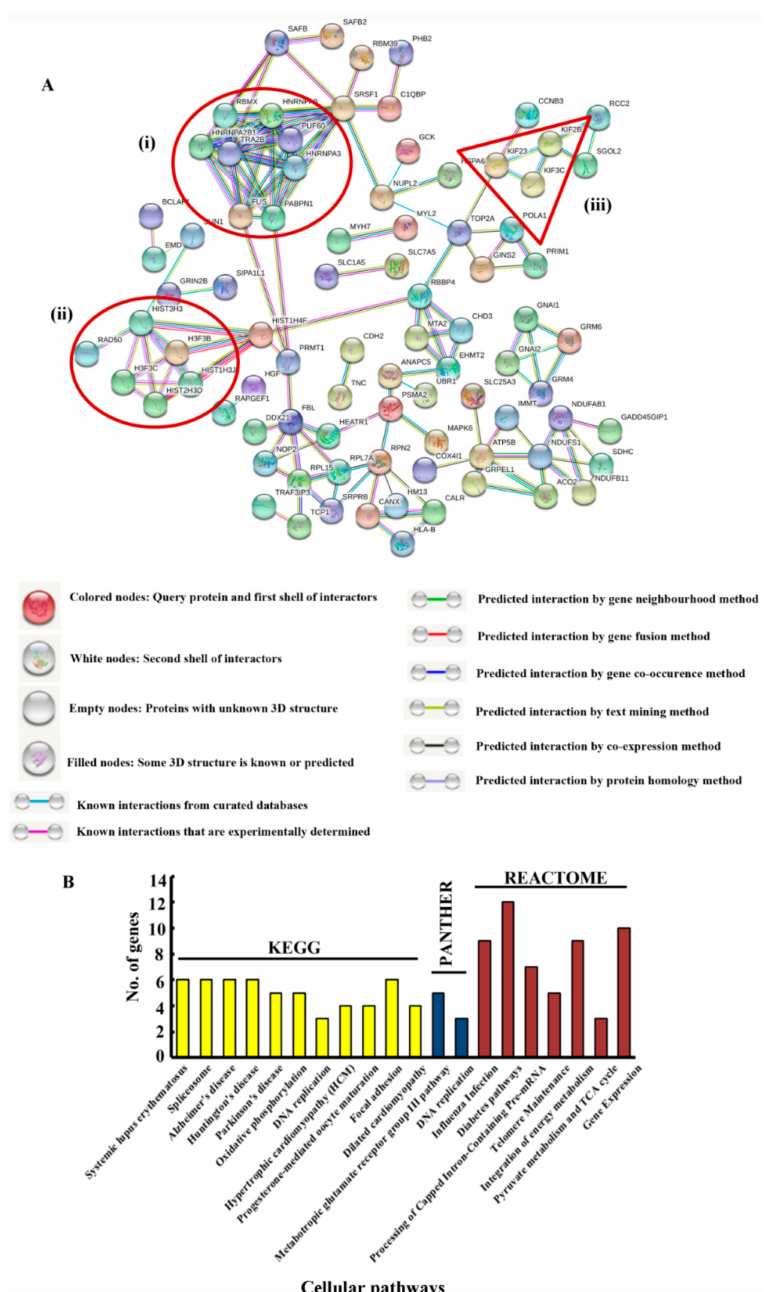
Figure 4. ( A ) The interactome of the downregulated proteins obtained from STRING v 11.0. The cluster corresponding to the ( i ) gene expression, ( ii ) DNA replication and repair and ( iii ) microtubule kinesins have been demarcated. Color coding of the nodes and networks is stated below the STRING output. ( B ) Gene Ontologies enriched by the upregulated proteins (pathways enriched as analyzed by